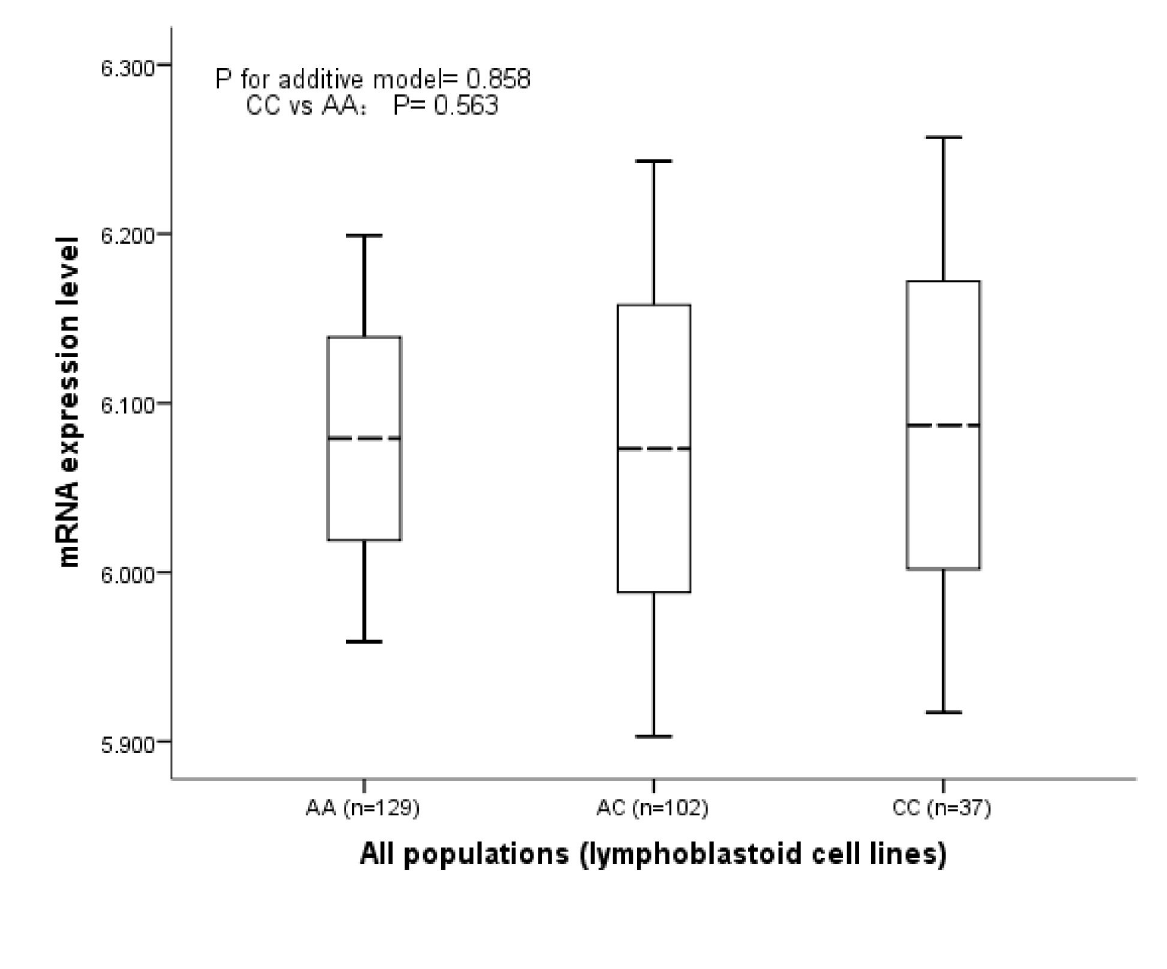
Figure 2. The mRNA expression level of YAP1 gene in all four populations of the HapMap cell